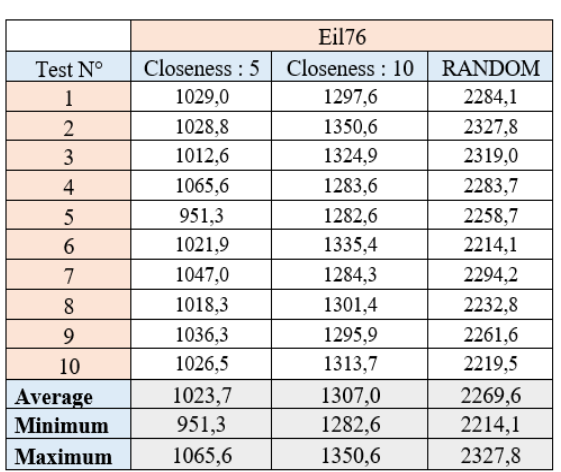
Fig 11. Berlin52 path after iteration number 1 :